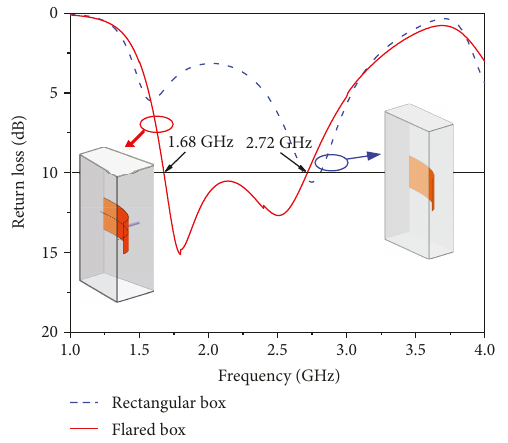
Figure 4: Improvement of impedance matching when a fl ared metal box is used.